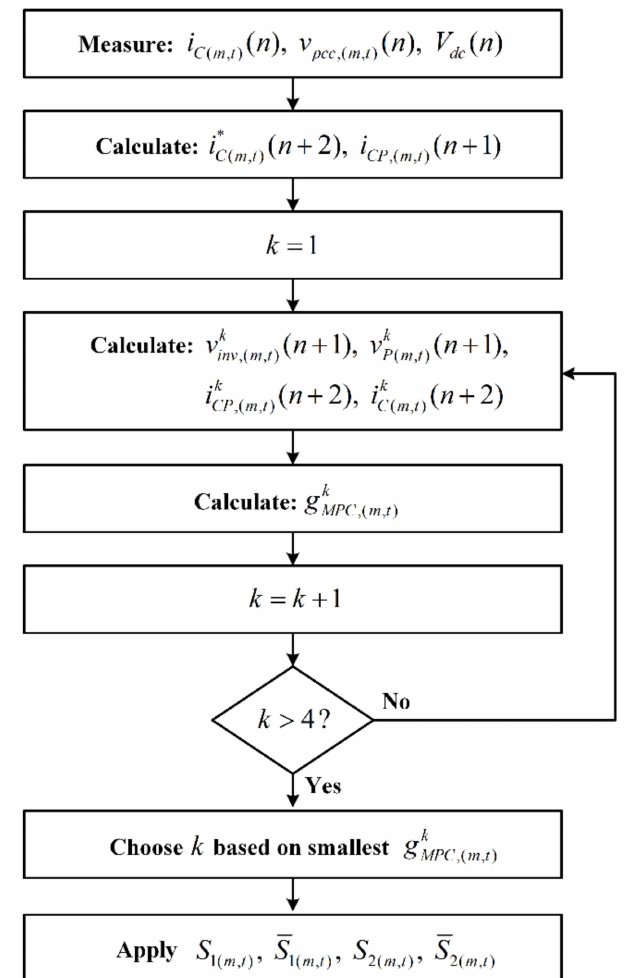
Figure 5. The MPC flow diagram for each sampling